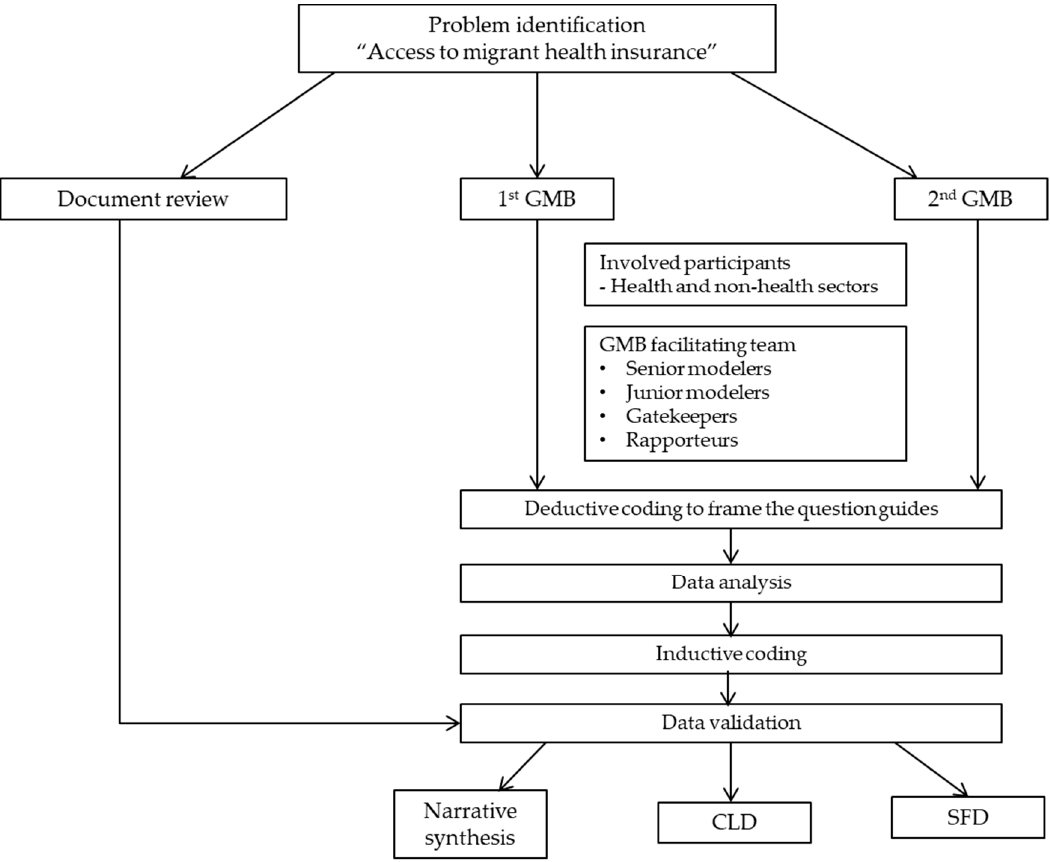
Figure 2. The process of data analysis.